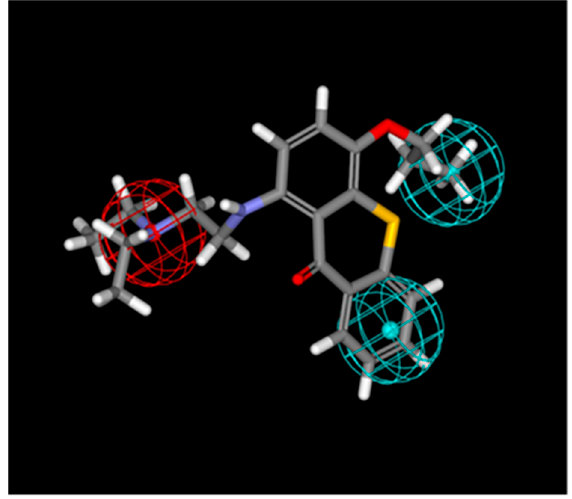
Figure 3. TXA1 mapped to the pharmacophore for autophagy induction. The red sphere represents the positive ionizable group and the blue sphere represents the hydrophobic region.